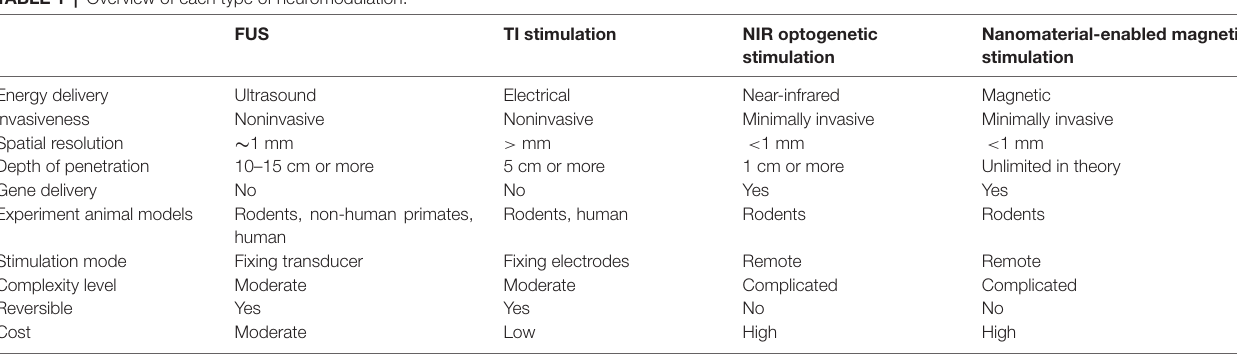
TABLE 1 | Overview of each type of